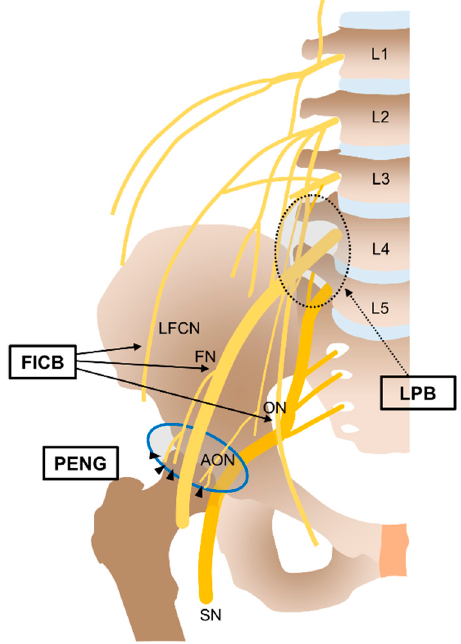
Figure 2. Illustration of the target nerves according to the type of regional nerve block. The fascia iliaca compartment block (FICB) targets the lateral femoral cutaneous (LFCN), femoral (FN), and obturator nerves (ON). The lumbar plexus block (LPB) targets the lumbar plexus (FN, ON, and LFCN) (dotted circle). The pericapsular nerve group (PENG) block mainly targets the articular branches (black arrowhead) of the FN and accessory obturator nerve (AON) (blue solid circle). SN: Sciatic nerve.